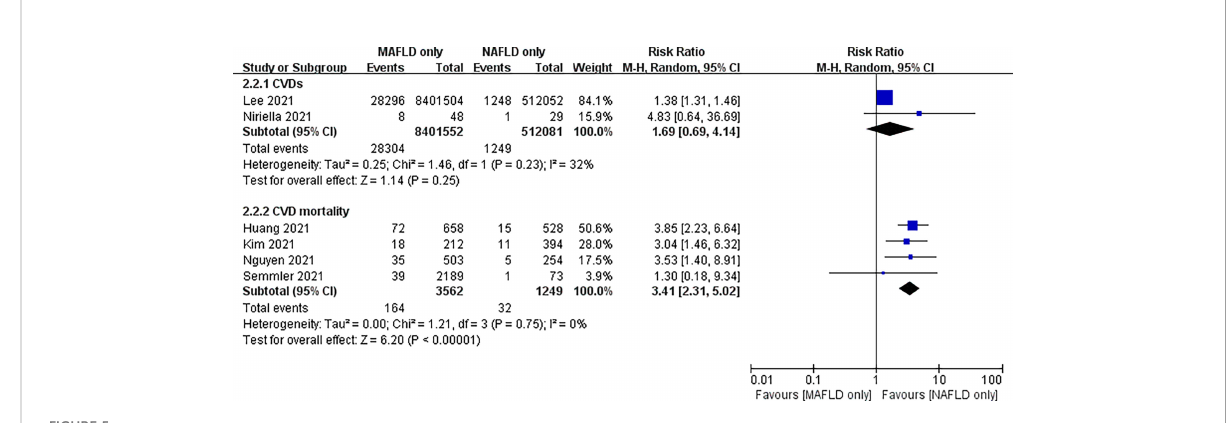
FIGURE 5 Subgroup analysis of CVD incidence and CVD mortality in the MAFLD-only group and the NAFLD-only